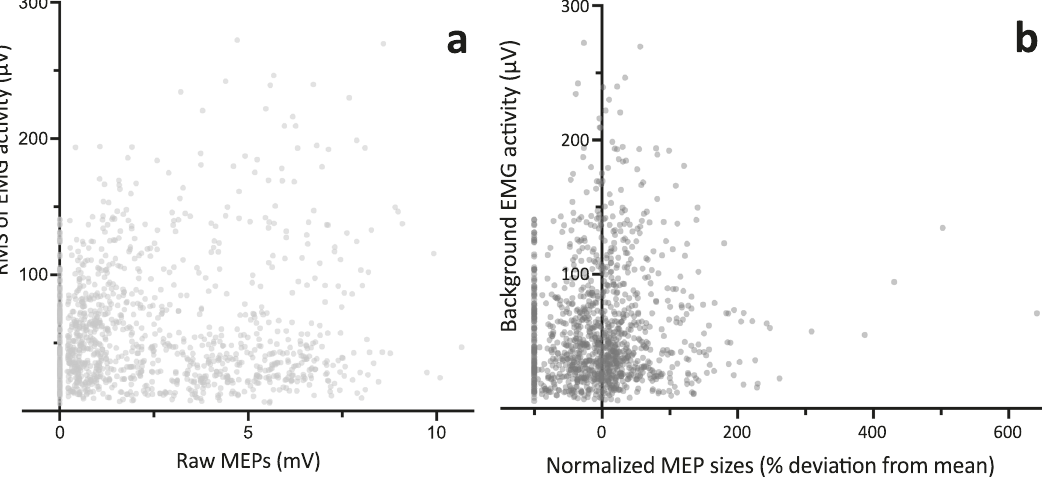
Fig. 3 Control analysis - relation of pre-stimulus EMG activity and MEPs. Spearman ’ s rho correlation analysis between background EMG activity 110 – 10 ms before stimulation (RMS, root mean square) and MEP size. a . Correlation with raw MEPs before normalization ( r = − 0.0267, 95% CI − 0.0861 – 0.0329, p = 0.3651). b Correlation with normalized MEPs ( r = 0.056, 95% CI − 0.0032 – 0.1155, p =